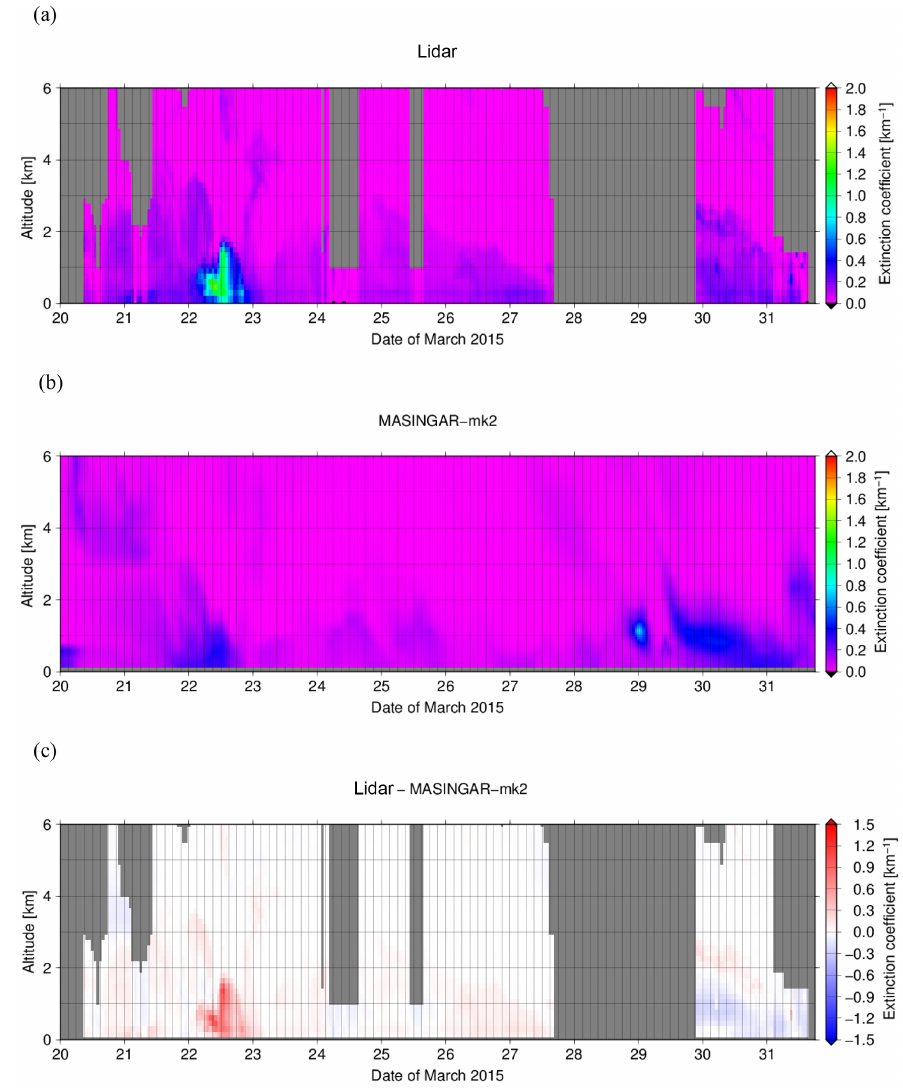
Figure 5. Time–altitude cross sections of (a) aerosol extinction coefficients observed by Mie lidar at 532nm over Saga from 09:24JST on 20 March to 14:34JST on 31 March 2015, (b) the coefficients simulated by MASINGAR-mk2 at 550nm for 20–31 March 2015, and (c) the difference between the Mie lidar observations and the simulation (a–b) . Gray regions represent areas where there were no observational